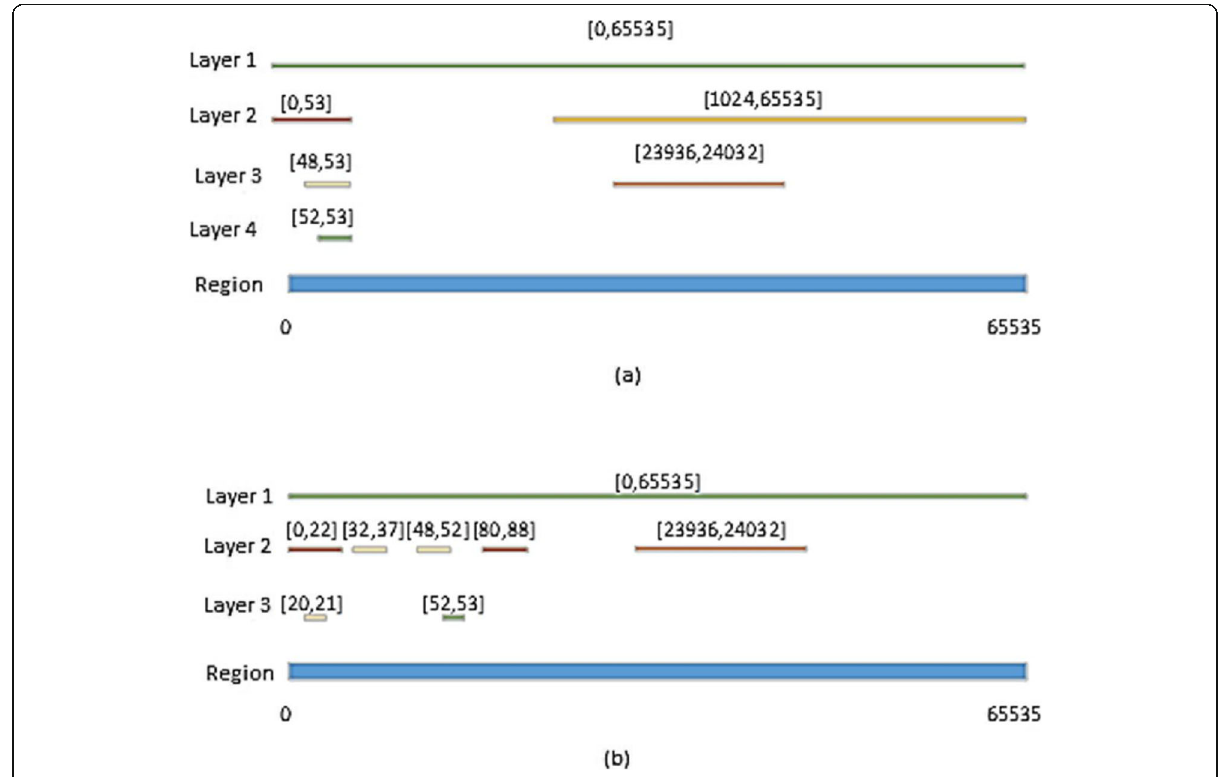
Fig. 6 Layering the range of the ports according to the rules in Table 1 a source port ranges; b destination port